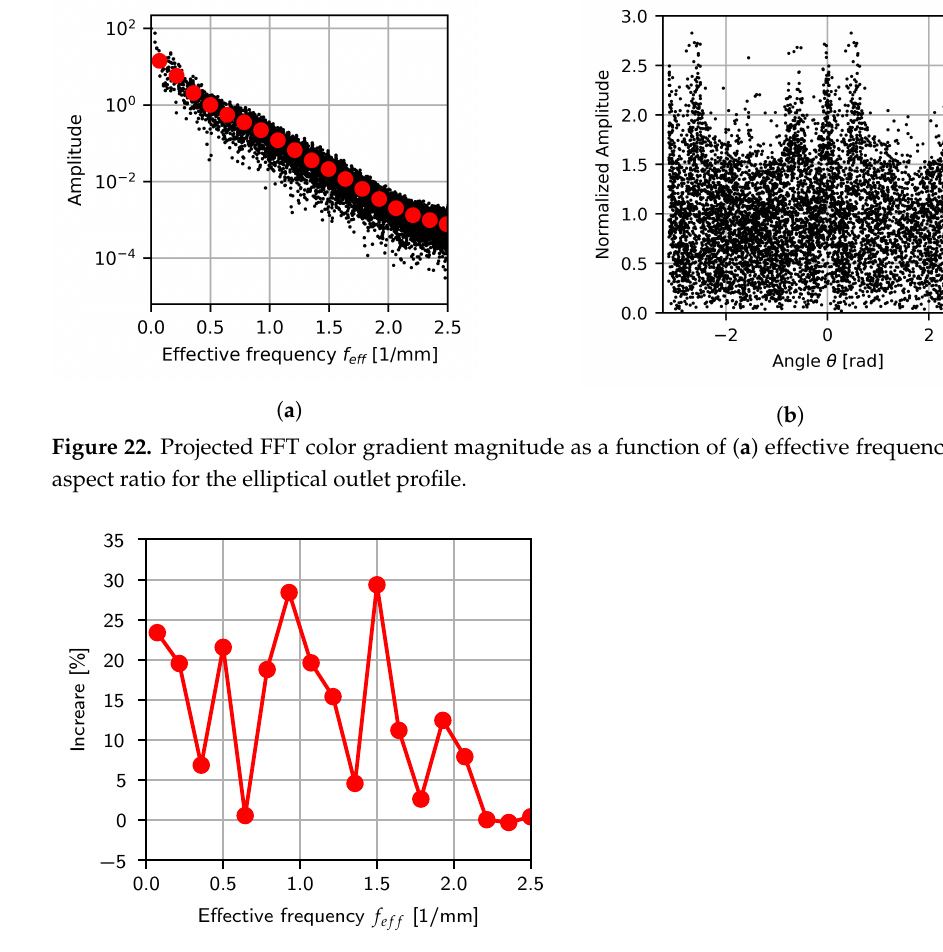
Figure 23. Percentage increase in the binned color gradient magnitude FFT results over the effective frequency